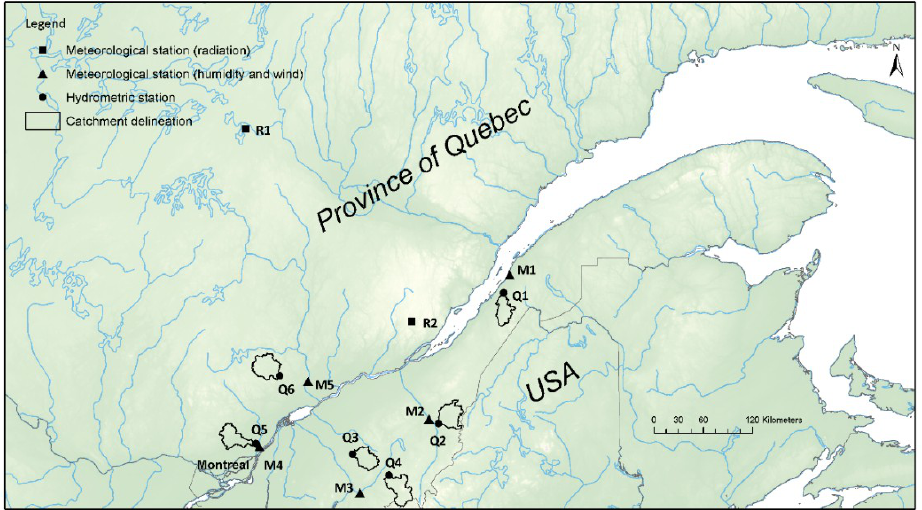
Figure 1. Location of the outlet of the six catchments (circles) and of the nearest meteorological stations (triangles and squares) from which humidity, radiation and wind speed observations are extracted.